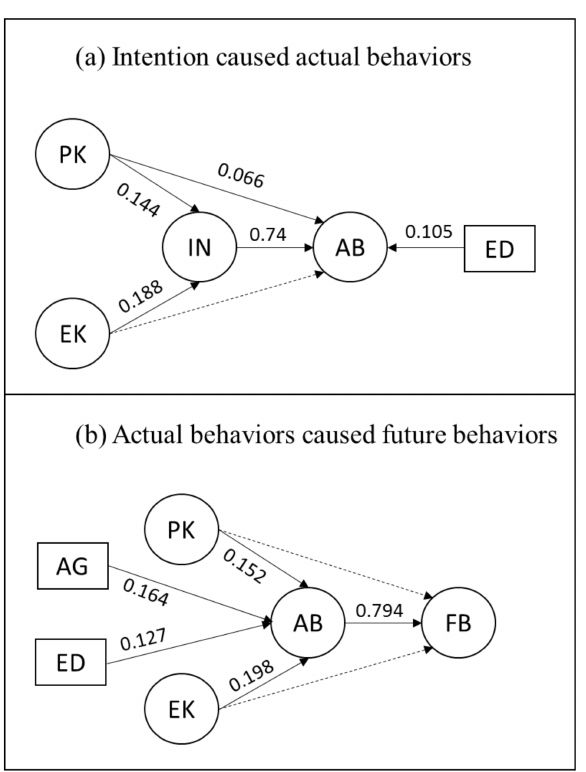
Figure 1. Path diagram of structural equation model (SEM) of pro-environmental behaviors based on two scenarios. The solid lines indicate significant relationships, while dash lines indicate non-significant relationships between plant knowledge (PK), environmental knowledge (EK), pro-environmental intentions (IN; FB), and pro-environmental behaviors (AB). Demographics include gender (G), age (AG), and education (ED).